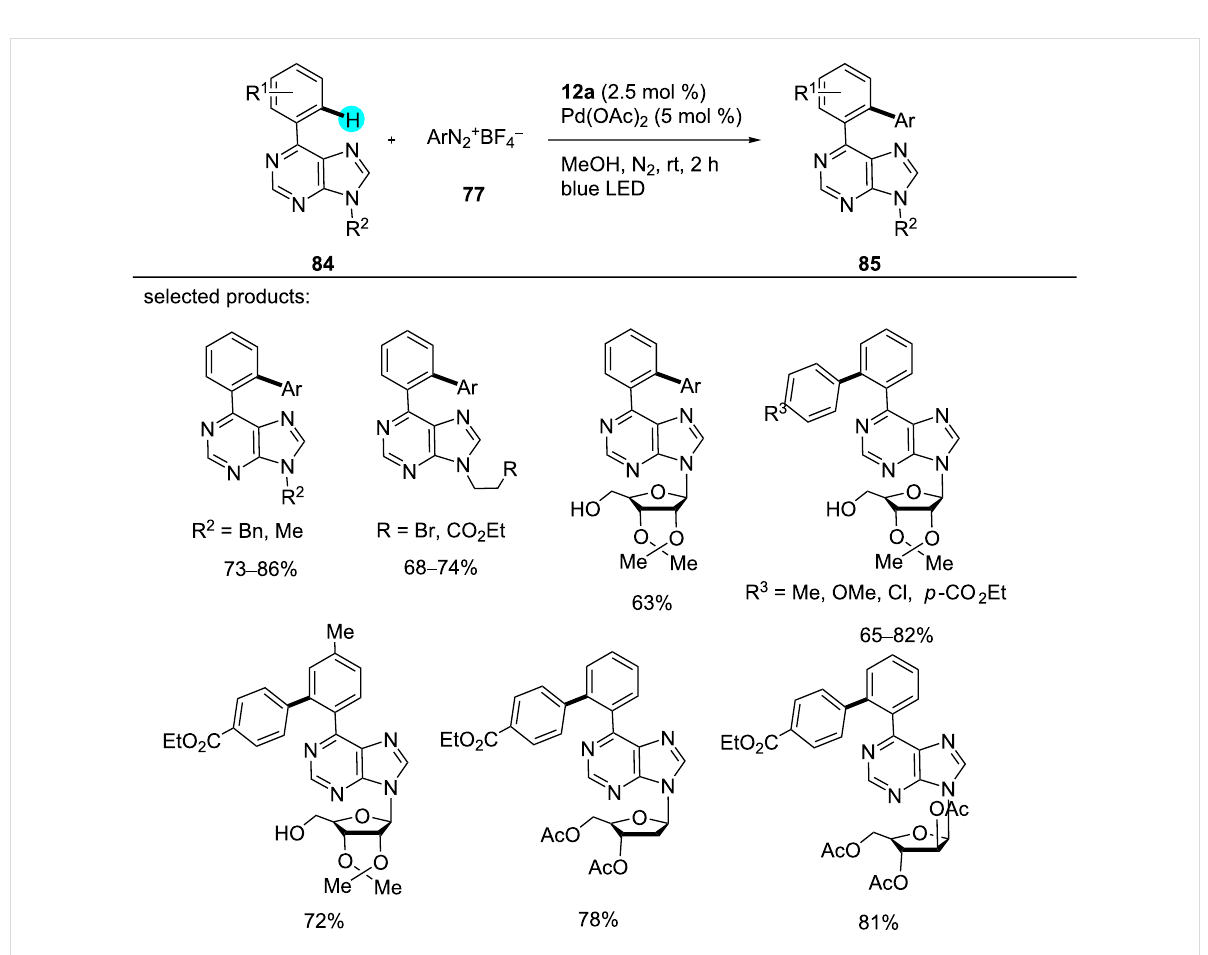
Scheme 11: Arylation of purines via dual photoredox